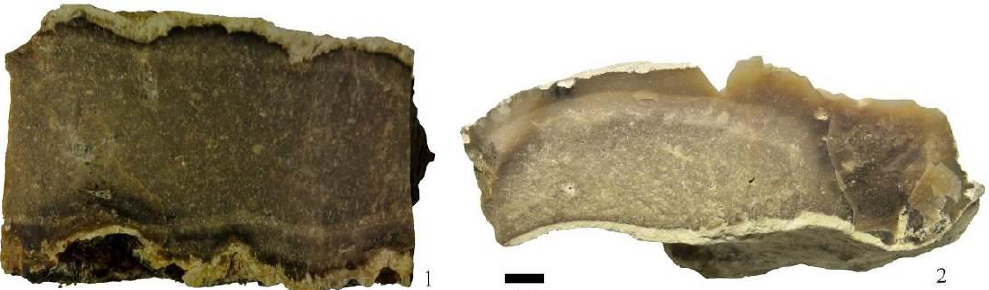
Figure 12. 1: Detail of a nodule with striping and infra-cortex line. 2: Nodule with a rough light grey area not fully silicified.